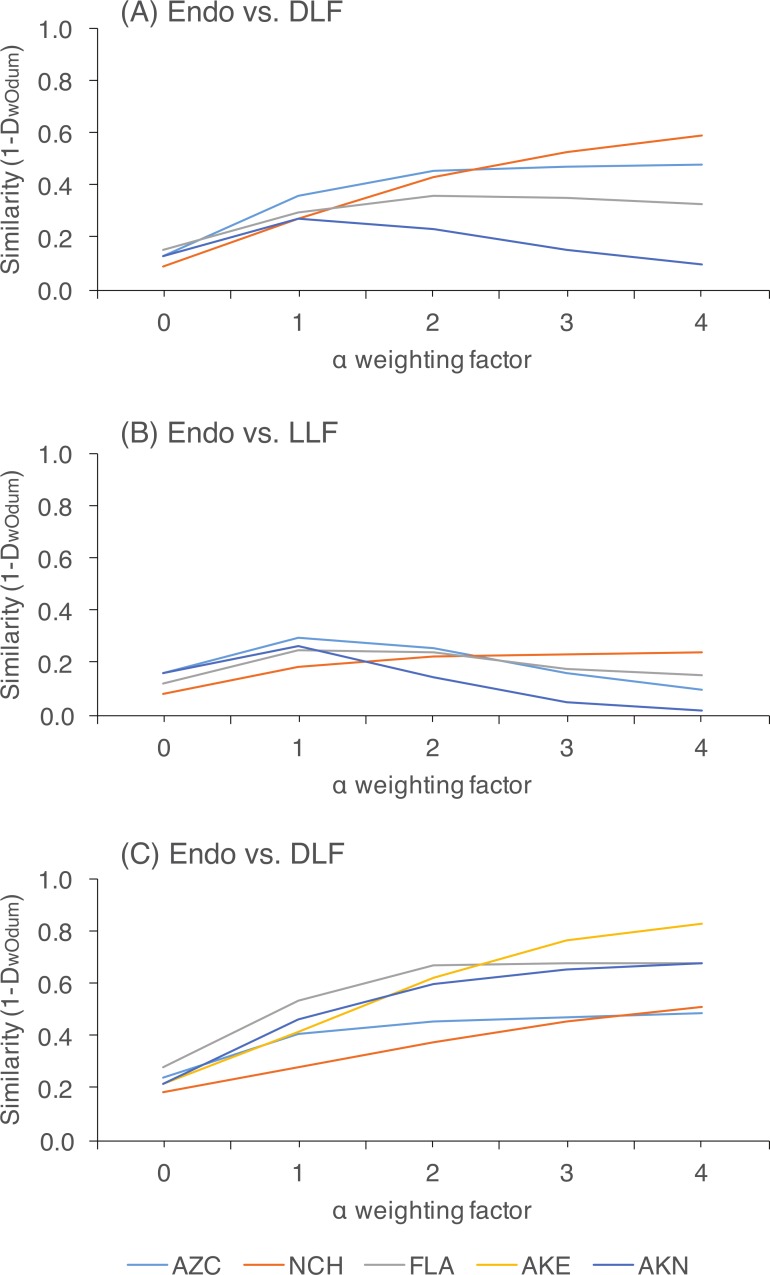
Pairwise community similarity among different leaf types as a function of site.Similarity is measured as 1-DwOdum, as calculated in OTUshuff using 1,000 Monte Carlo iterations. Similarity was assessed at different alpha weighting factors (i.e., when α = 1, DwOdum is equal to DOdum; when α < 1, the influence of abundant taxa will be down-weighted; and when α > 1, the influence of low abundance taxa will be down-weighted). Low sample size of endophytes precluded comparisons of endophyte and DLF/LLF at AKE.